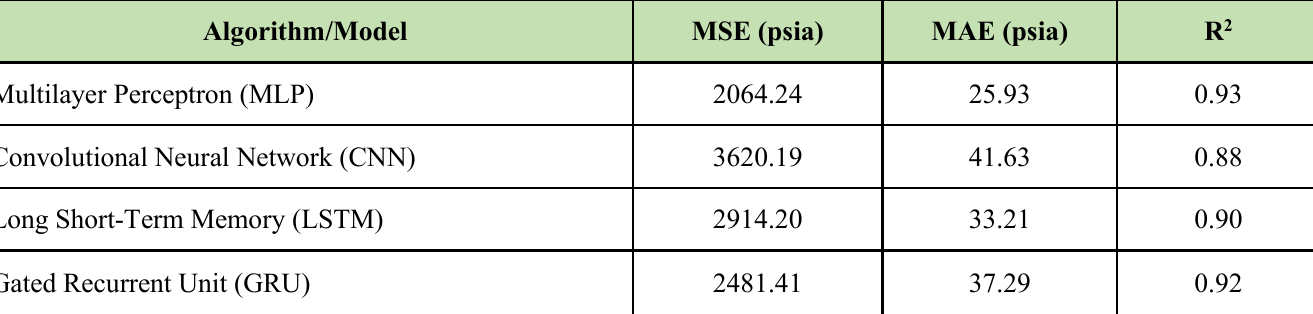
Figure 4 — Test Case 3 with Deep Learning Algorithms: Dataset (Top Right); Oil Rate vs Time – Full Dataset (Bottom Left); Oil Rate vs Time – Test Dataset (Bottom Right). Table 2 — Performance metrics for the four deep neural networks (Test Case